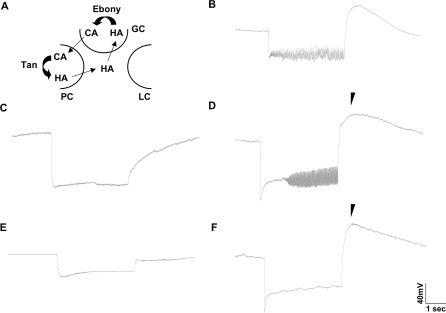
Ebony, But Not Tan, Activity Is Required for the ine Mutant ERG Phenotype(A) Simplistic diagram showing the recycling of histamine in the Drosophila eye. HA, histamine; CA, carcinine; PC, photoreceptor cell; LC, postsynaptic laminar cell, and GC, glial cell. Histamine is taken up from the synaptic cleft by glial cells where it is converted by ebony into carcinine. Carcinine is then shipped to photoreceptor cells where it is converted back to histamine by the enzyme tan. ERG recordings from (B) ine2, (C) tan, (D) tan1;ine2, (E) ebony11, and (F) ine2;ebony11 flies. Note that ine2 oscillations are rescued by mutations in ebony but not in tan.